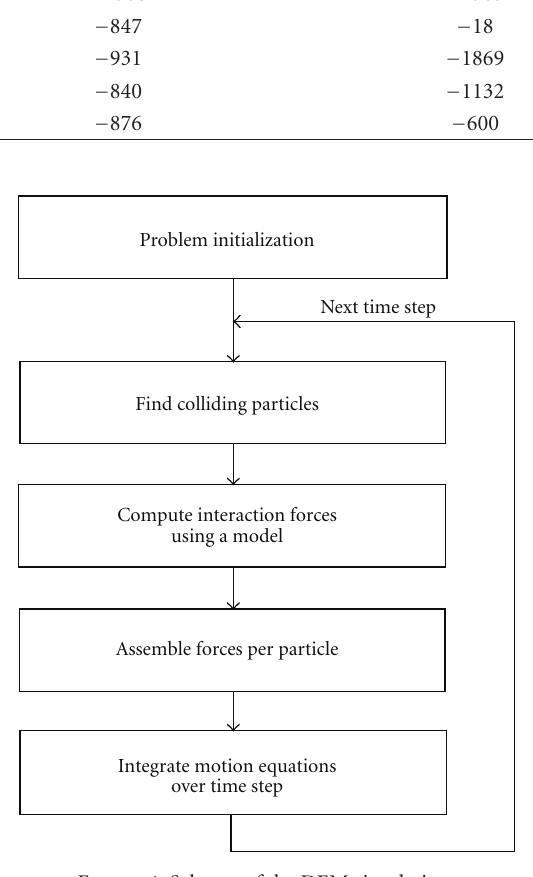
Figure 4: Scheme of the DEM